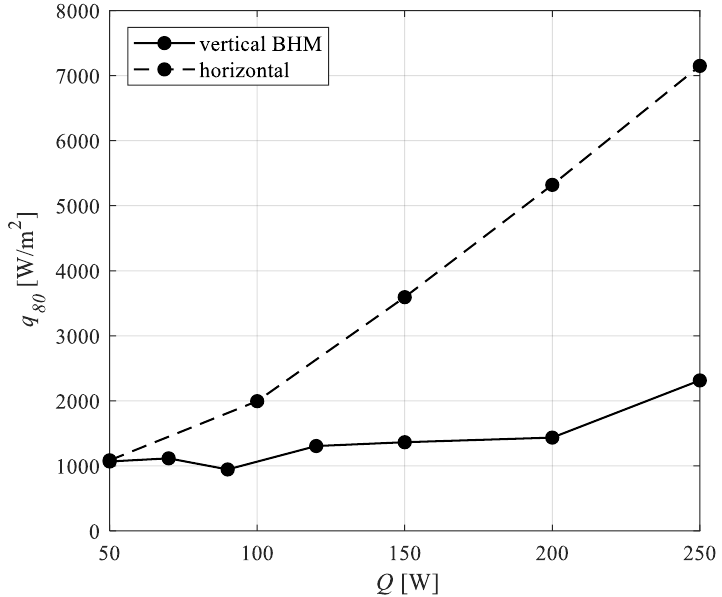
Figure 16. 80th percentile of the absolute value of q as a function of the heat load to the evaporator for the two considered orientations.